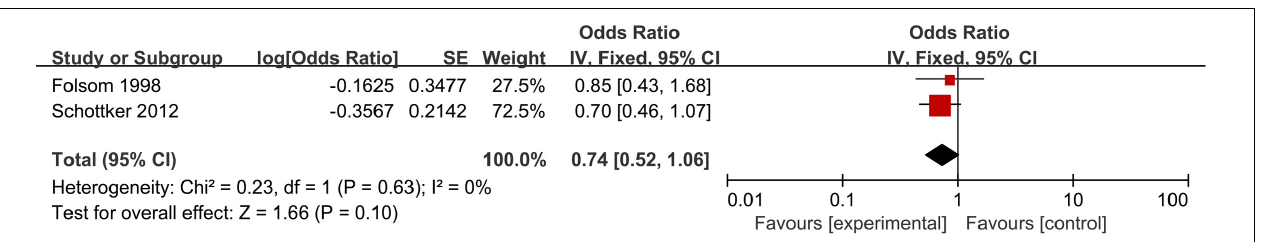
FIGURE 4 | Relationship anti- H. pylori IgG test and CHD in studies reporting